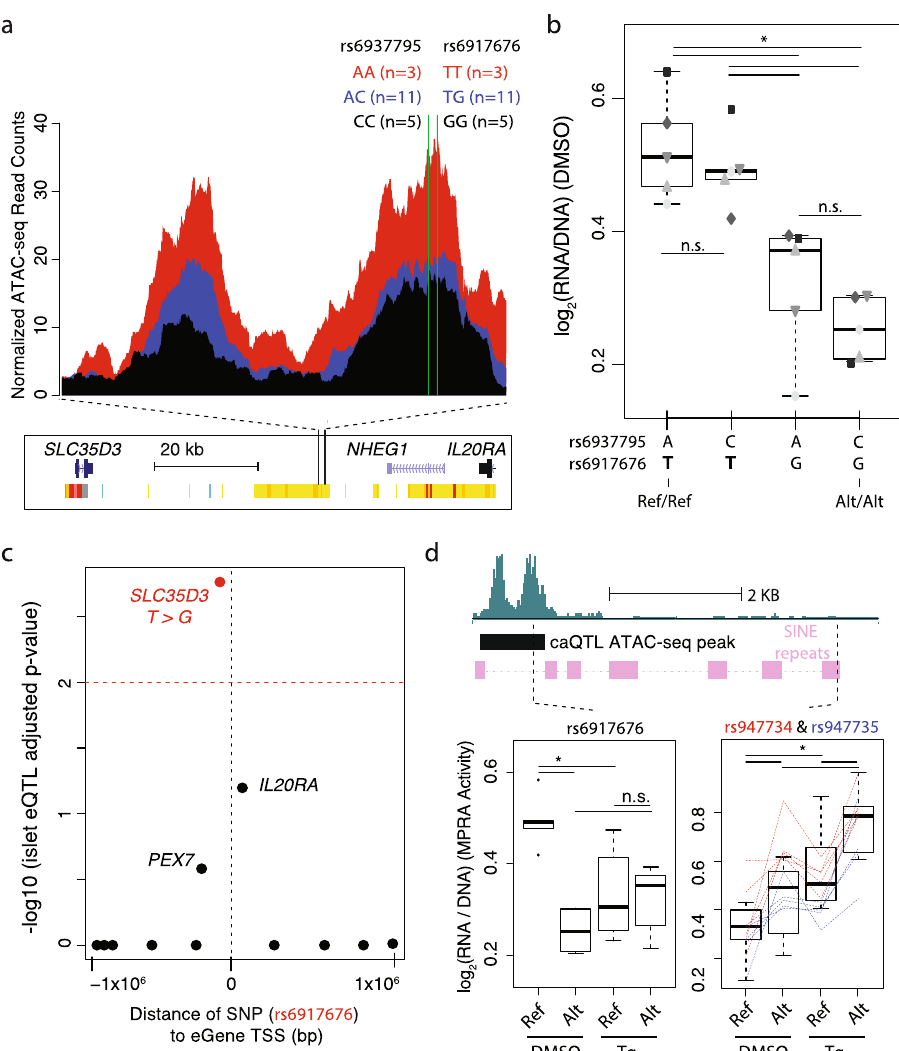
Fig. 5 MPRA re fi nes T2D-associated haplotype in SLC35D3 locus. a Islet caQTL in the SLC35D3 locus. Two T2D SNPs, rs6937795 and rs6917676 (15 bps apart; r 2 = 0.99; green lines), are both signi fi cantly associated with altered chromatin accessibility changes (caQTLs) in the SLC35D3 locus in islets from 19 different individuals. b MPRA activity (log 2 RNA/plasmid ratios) for each of the four possible rs6937795 and rs6917676 allelic combinations tested in the MPRA library. Only rs6917676 alleles altered MIN6 MPRA activity. The rs6917676 T allele is associated with both increased chromatin accessibility and MPRA activity. Shape/shading of points indicate the fi ve paired biological replicates for each MPRA experiment. c Plot of InsPIRE Consortium islet eQTL -log10 association p-values between rs6917676 genotypes and expression of genes ± 1 megabase from the SNP. d MPRA activity (log 2 RNA/plasmid ratio) of caQTL SNP rs6917676 (left), and two additional SNPs [rs947734 (red) and rs947735 (blue); 43 bp apart] that overlap the same SINE, in ER stress (Tg- treated) compared to DMSO control conditions. Red and blue dashed lines indicate relationships between alleles for each biological replicate. * denotes FDR < 10%. Box plots in panels ( b ) and ( d ) display the minimum, maximum, median, fi rst quartile and third quartile of each data set. Points outside the minimum and maximum values are